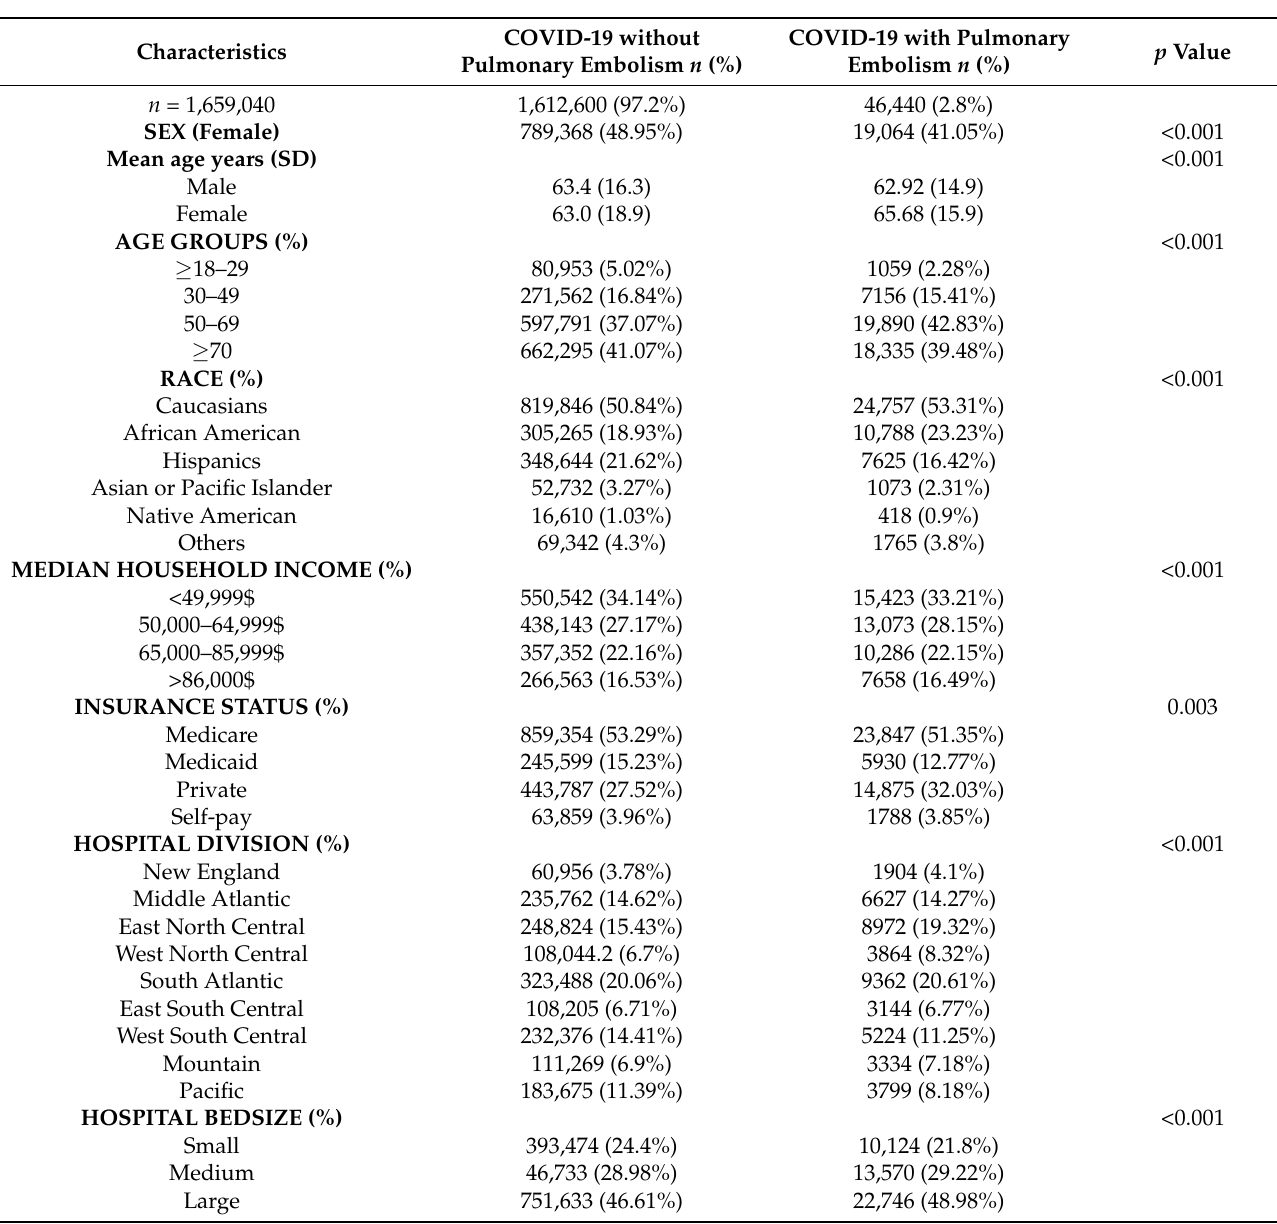
Table 1. COVID-19 and pulmonary embolism patient-level characteristics. SD = Standard devi- ation, CAD = Coronary Artery disease, CHF = Congestive heart failure, HTN = Hypertension, DM = Diabetes